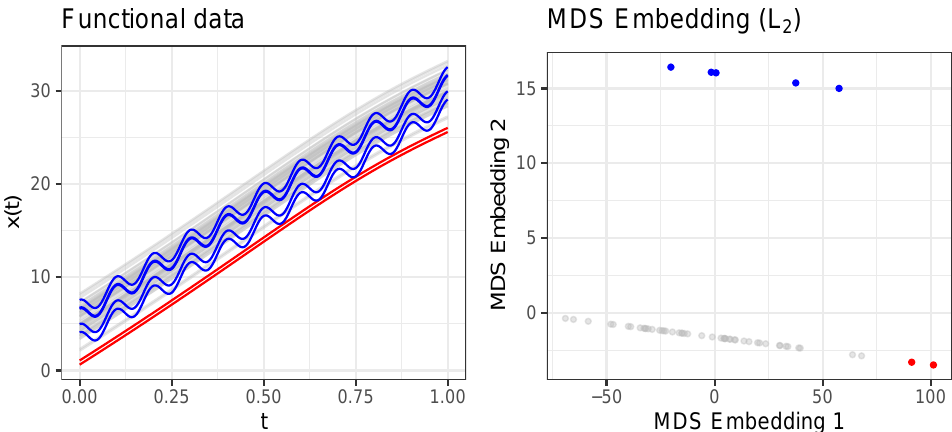
Figure 3. Functional outlier scenario ( n = 54, r = 0.09) with shape variation inducing structural differences. Off-manifold outliers colored in blue; two on-manifold outliers colored in